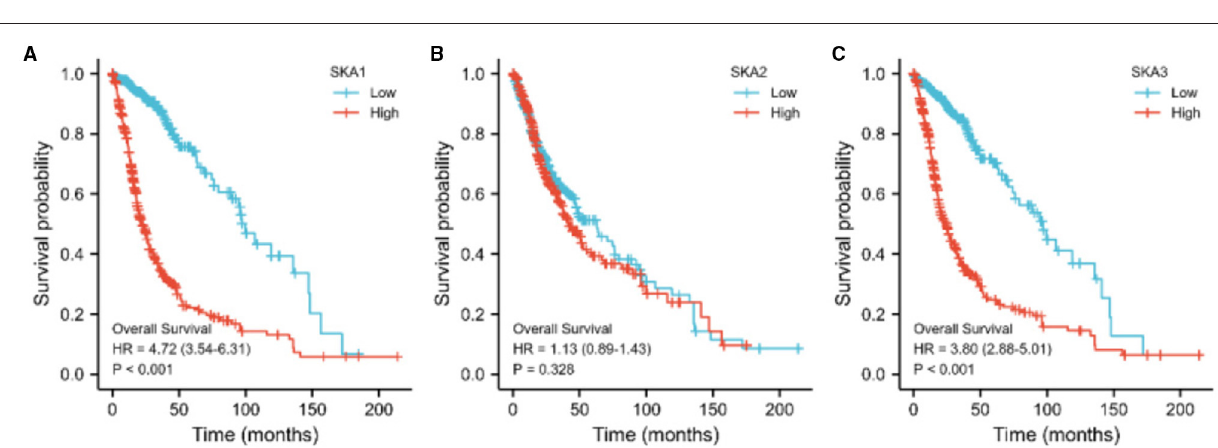
of all three SKA genes was correlated with the WHO grade and 1p/19q codeletion ( Table 1